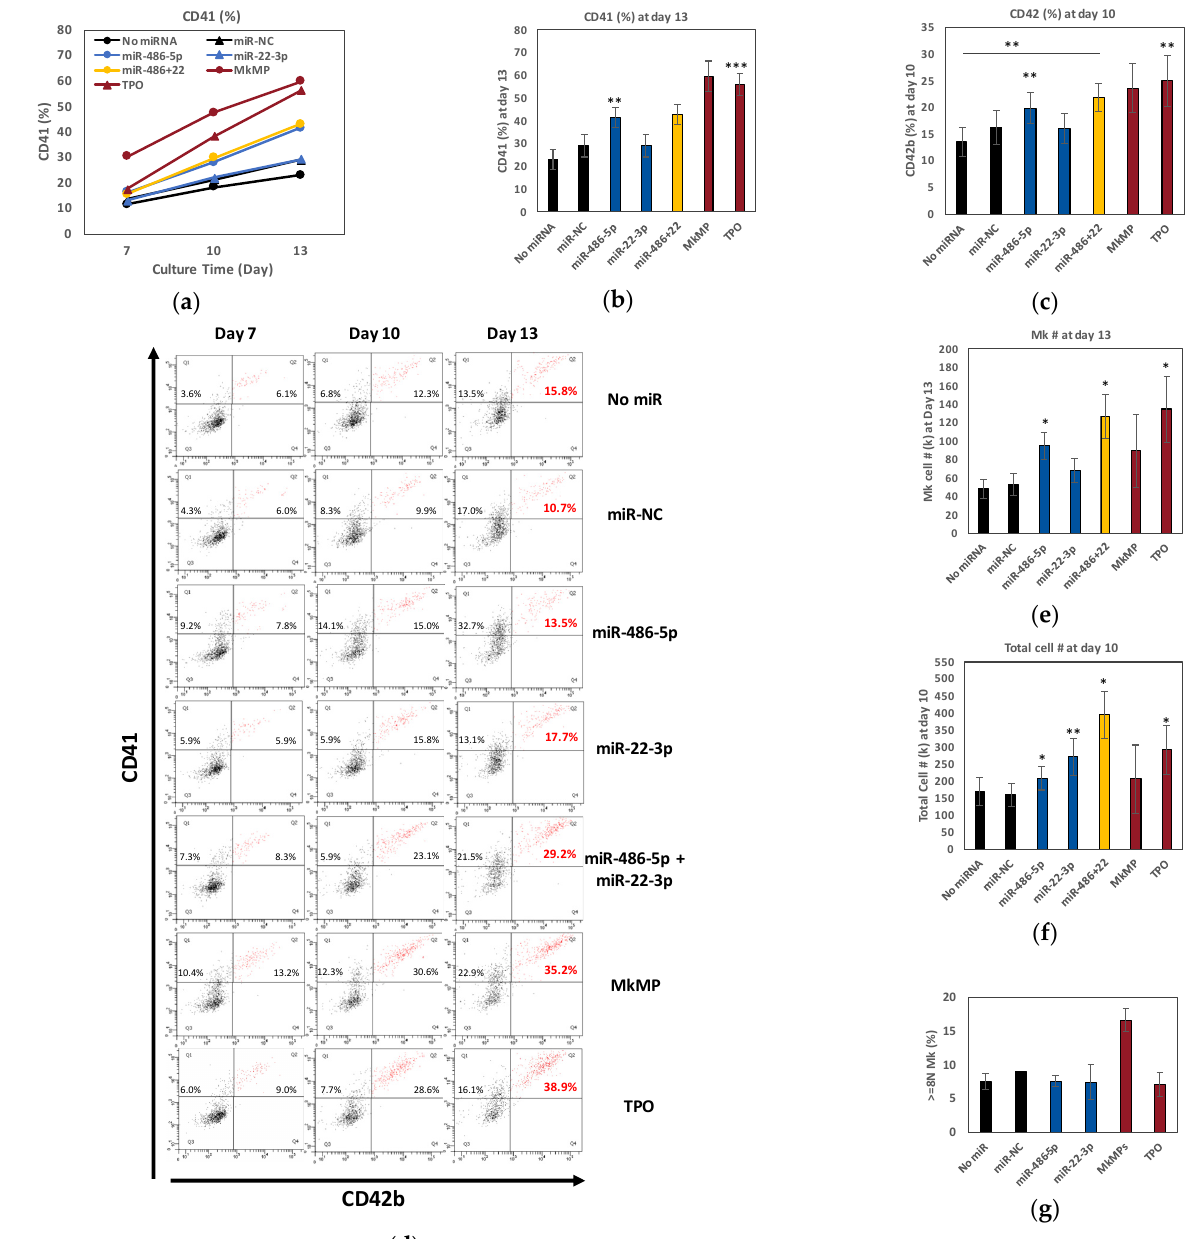
Figure 2. The effect of single or multiple miRs on Mk differentiation. CD34 + HSPCs were transfected with miR mimics (N = 8), miR negative control (miR-NC, N = 8), or without miRs (No miR, N = 8), and cells were cultured in minimal medium (IMDM supplemented with 10% BIT and 50 ng/mL SCF) without TPO. Cells cultured in TPO-supplemented medium (100 ng/mL TPO, N = 6) or cells co-cultured with MkMPs (N = 3) served as positive controls (TPO, MkMP). Cells were harvested for flow cytometric analysis for ( a , b ) CD41 expression at days 7, 10 and 13, and ( c ) CD42b expression at day 10. ( d ) Representative flow cytometric dot plots for CD41 and CD42b expression at day 7, 10 and 13 with quadrant gates. ( e ) Mk (CD41 + ) cell numbers at day 13, or ( f ) total cell numbers at day 10 were measured by flow cytometry, respectively. ( g ) At day 16, cells were harvested for ploidy analysis by flow cytometric analysis. Error bars in ( a – c , e – g ) represent the standard error of mean from 3-8 biological replicates. Statistical comparison analysis was performed between each experimental group against the two negative controls (No miR or miR-NC) unless otherwise shown on panel c. * p < 0.05, ** p < 0.01, *** p < 0.001. Electroporation of CD34 + HSPCs damages and alters the properties of CD34 + -cell membrane thus resulting in attenuated MkMP-induced Mk differentiation of CD34 + HSPCs (data not shown).